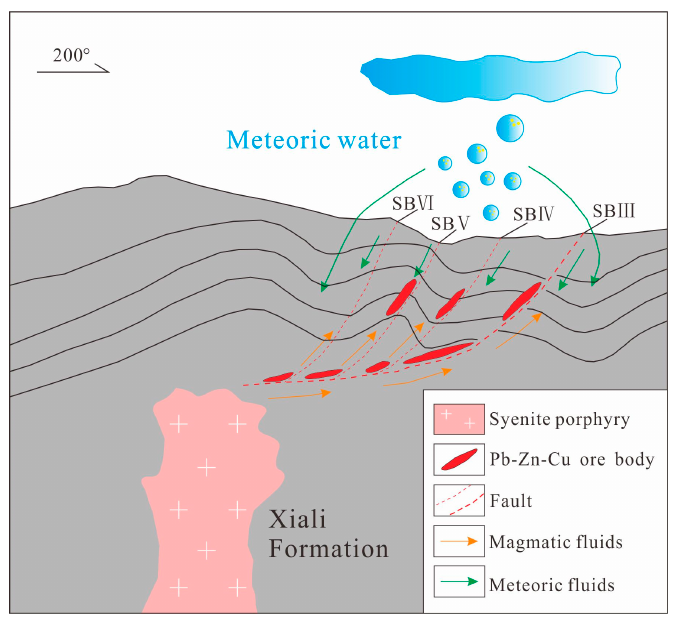
Figure 15. Metallogenic model for the Chuduoqu Pb-Zn-Cu deposit.